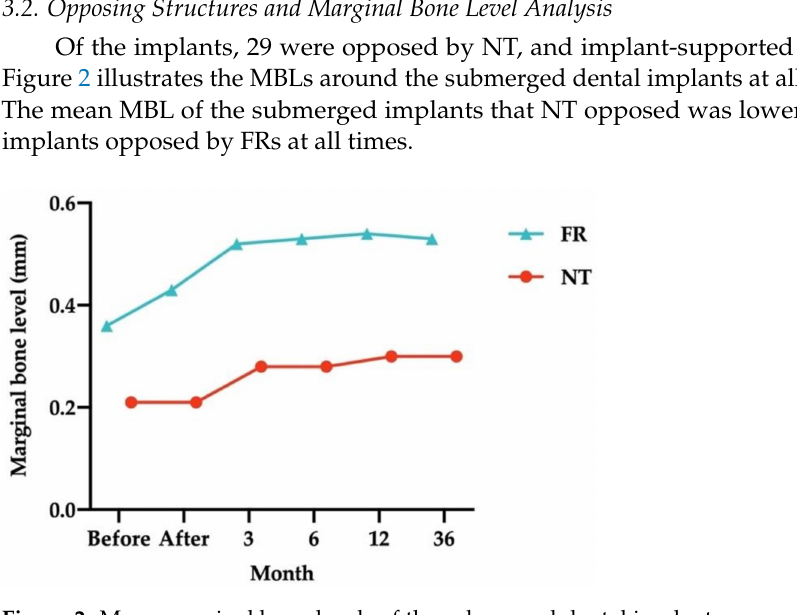
Figure 2. Mean marginal bone levels of the submerged dental implants opposed by natural teeth (NT) and fixed restorations (FRs) at all follow-up times. Measurements at the bottom of the graph refer to the time of implant